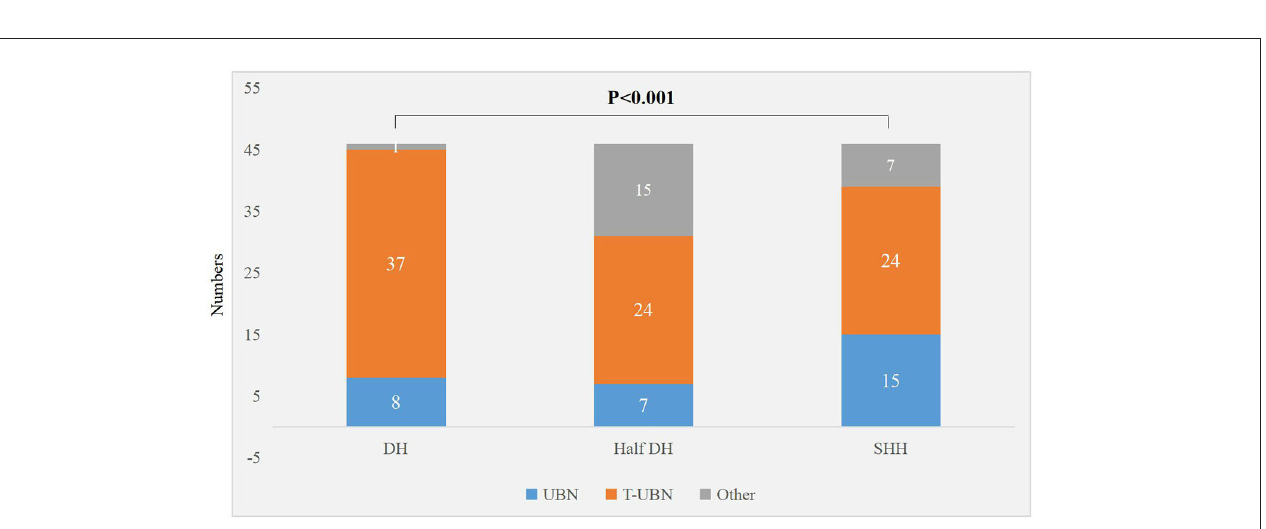
inconsistent with the side of the involved semicircular canal ( Table 3